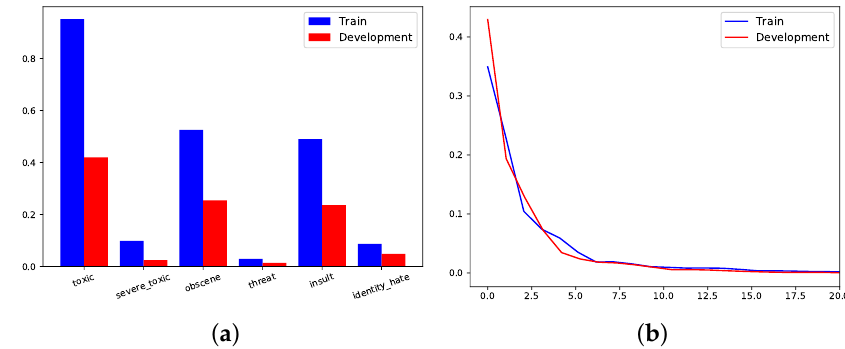
Figure 9. TOXIC Class Distribution ( a ) and frequency of unique class combinations ( b